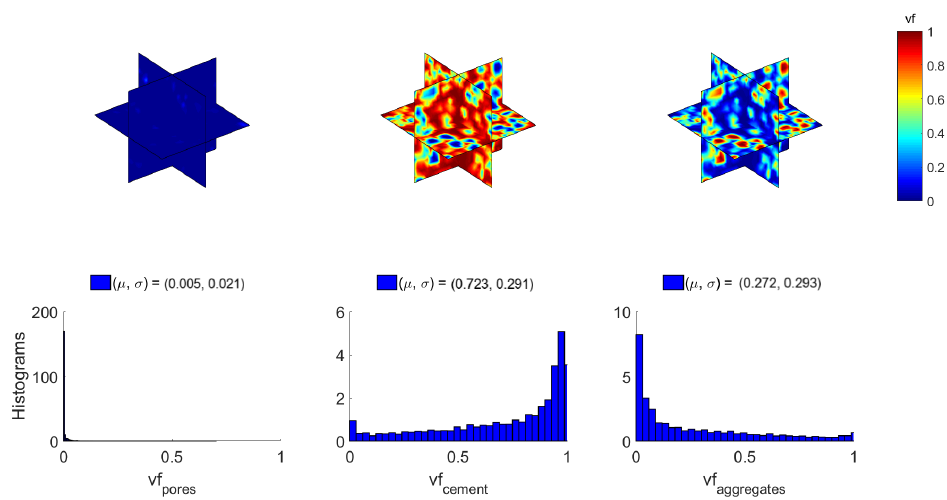
Figure 5. Random fields and histograms of volume fraction (vf) of concrete constituents for δ 1 .